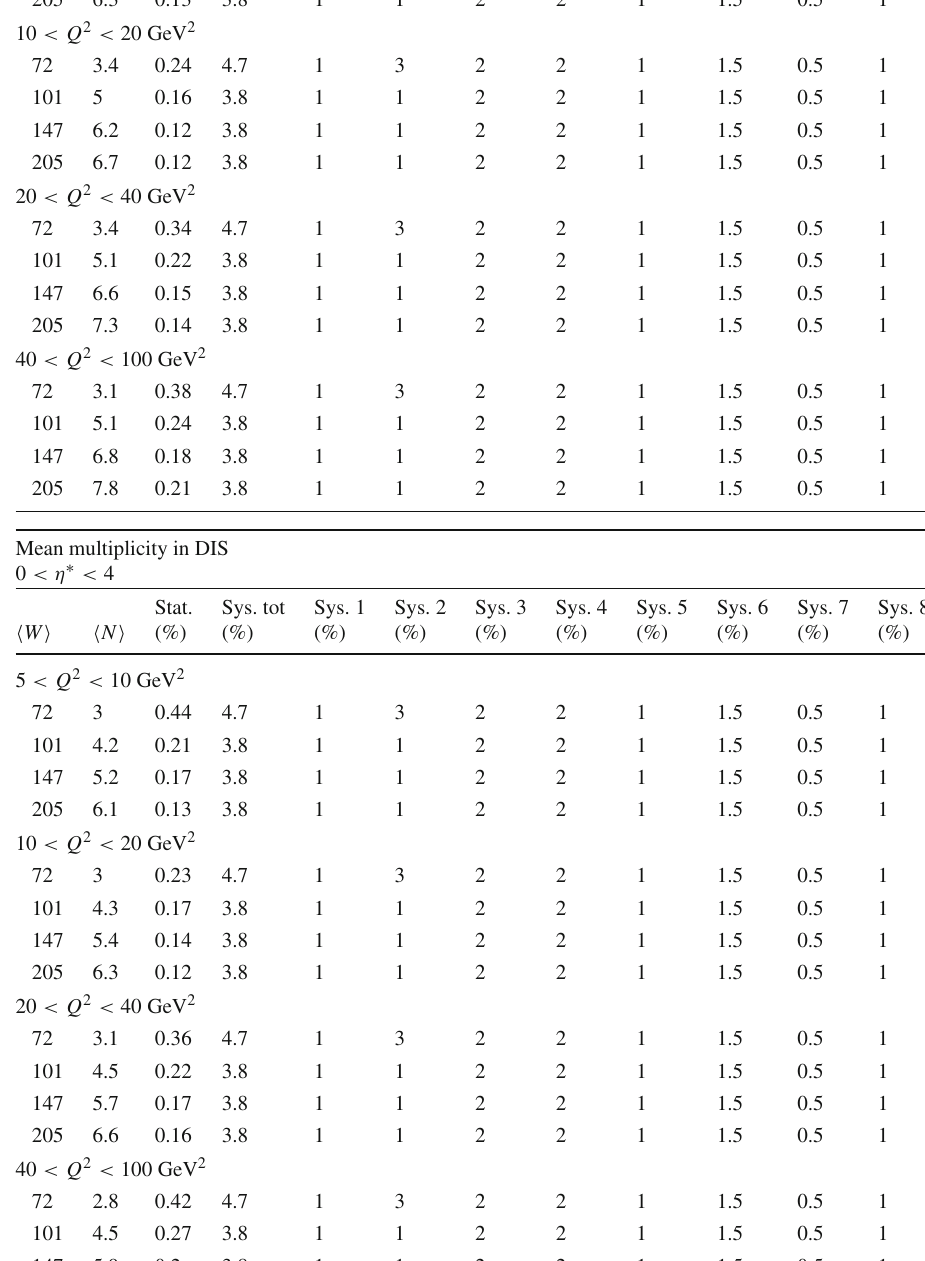
measured in ep DIS at √ s = 319GeVas a function of W . The measurement is repeated in four ranges of Q 2 as indicated. The phase-space is further restricted as shown in